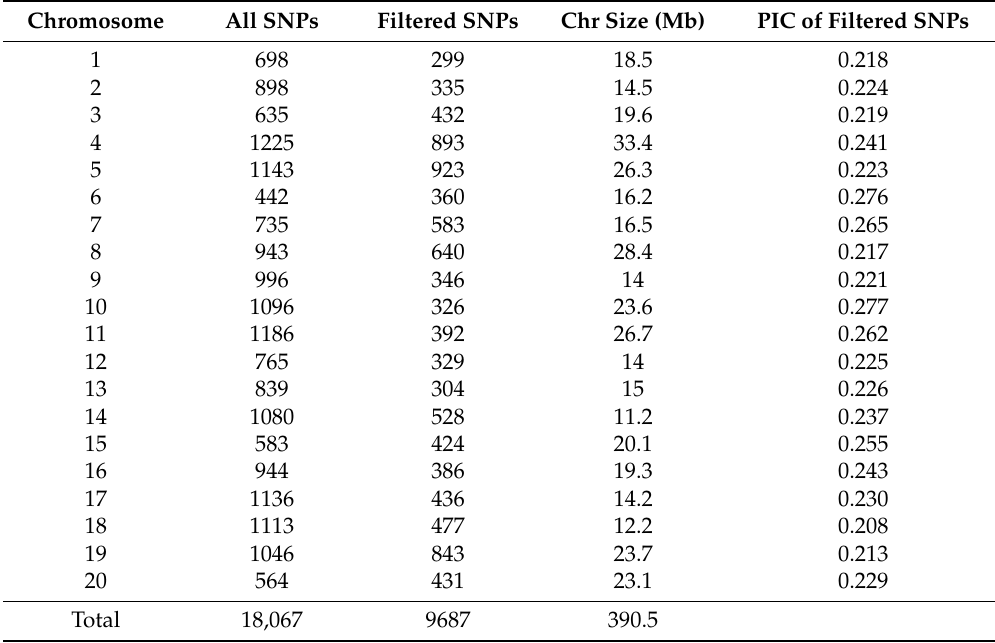
Table 2. Number of single nucleotide polymorphism (SNP) D. alata chromosomes before and after filtering alongside the average polymorphism information content